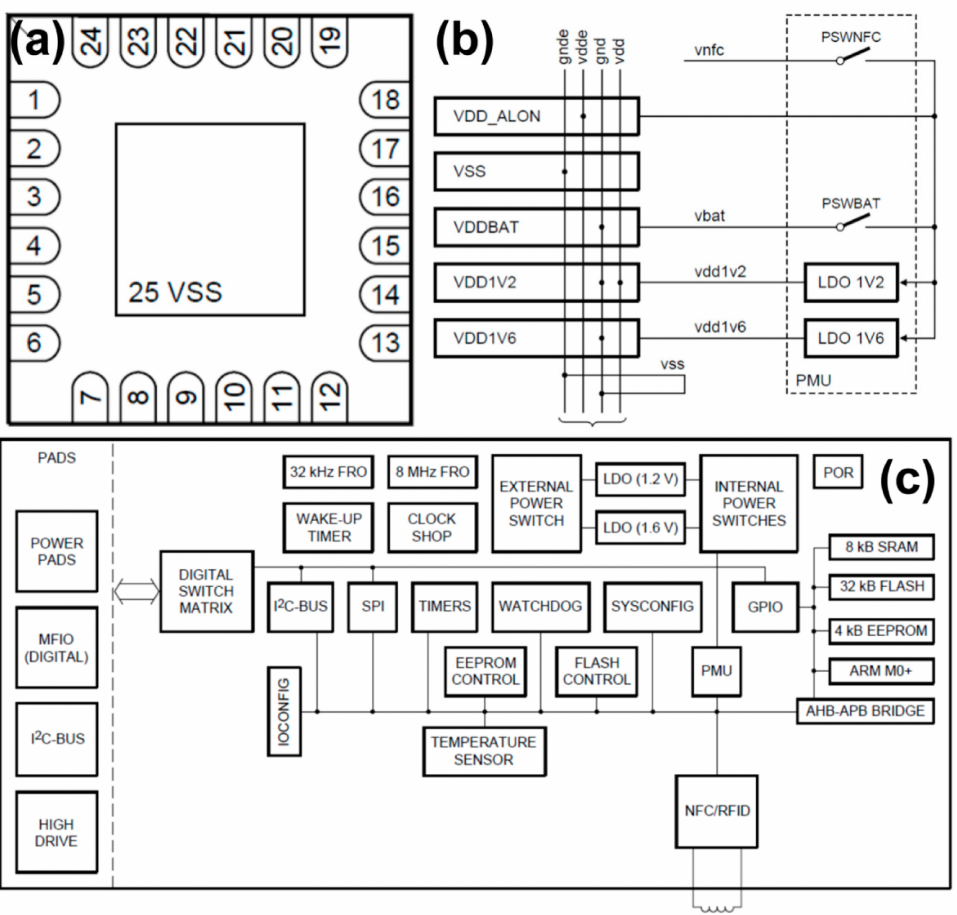
Figure 4. Diagram of NHS3100 with ( a ) chip package with golden relief; ( b ) power supply of the temperature patch connection; ( c ) overall schematic diagram of NHS3100